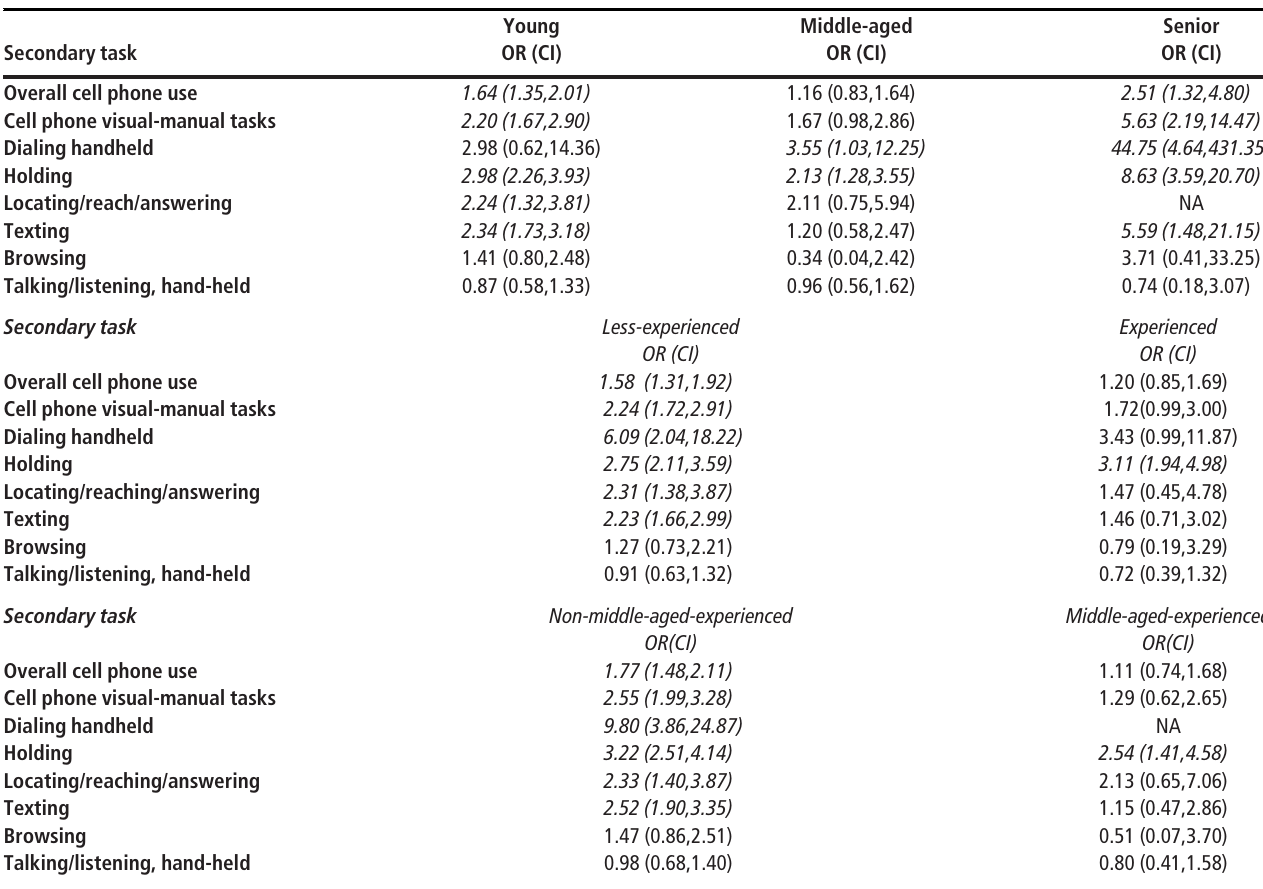
Table AII ORs (with 95% CI) of the Cell phone use by driver demographics Secondary